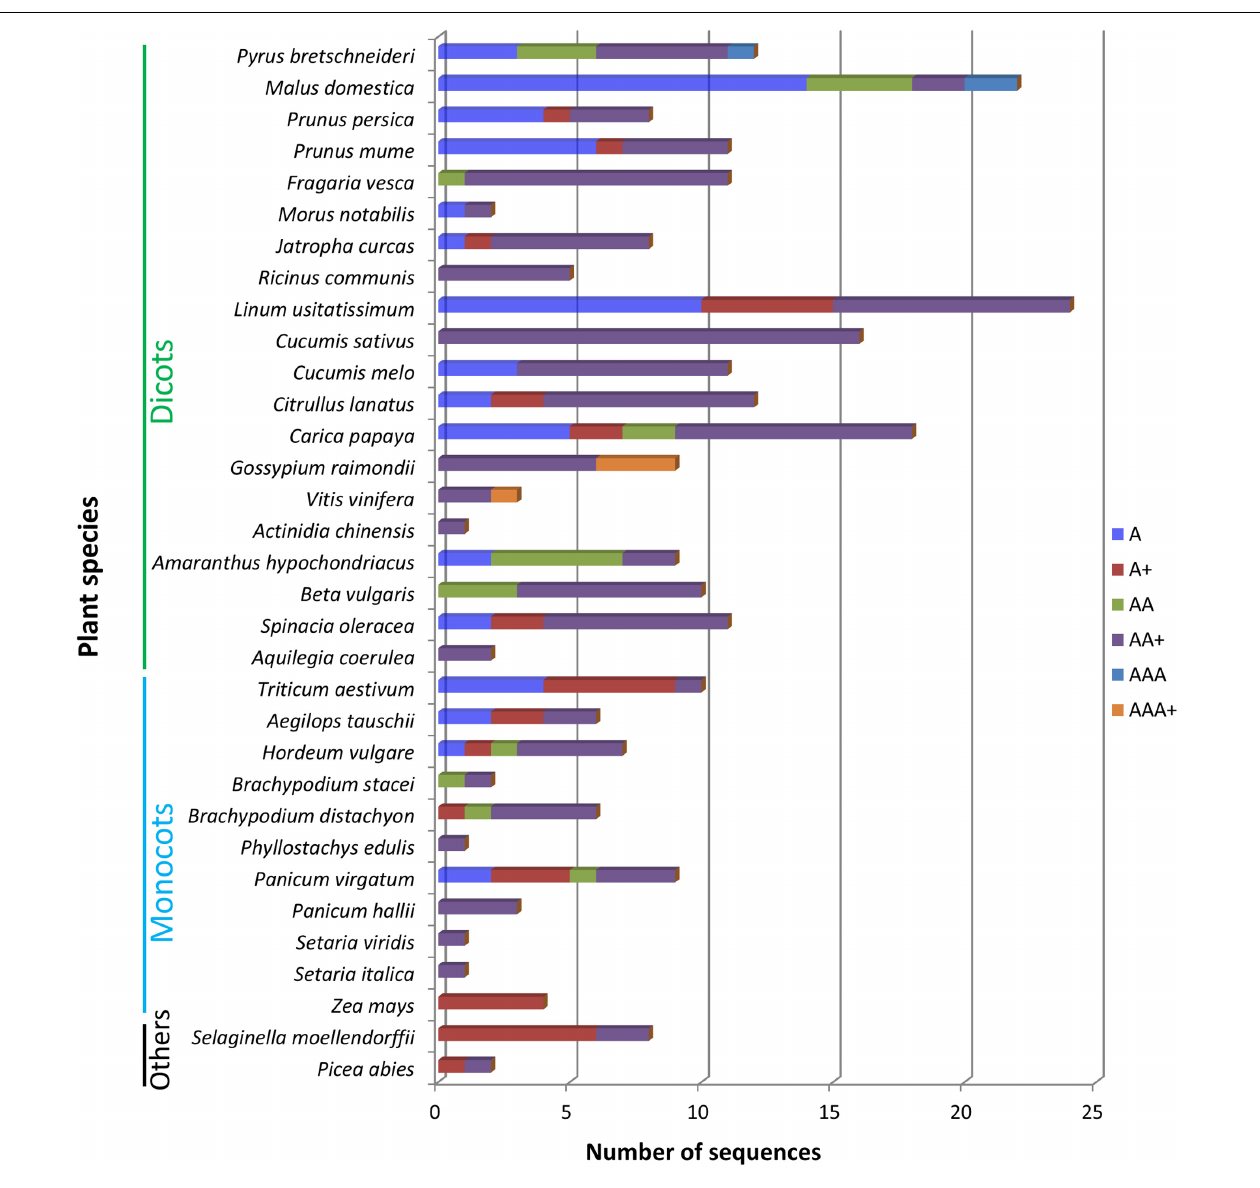
FIGURE 3 | Different types of domain architectures in studied plant genomes. A, single amaranthin domain proteins; A+, proteins with single amaranthin domain linked with another protein domain; AA, double amaranthin domain proteins; AA+, proteins with double amaranthin domains in combination with another protein domain; AAA, proteins with triple amaranthin domains; AAA+, proteins containing three amaranthin domains and one aerolysin